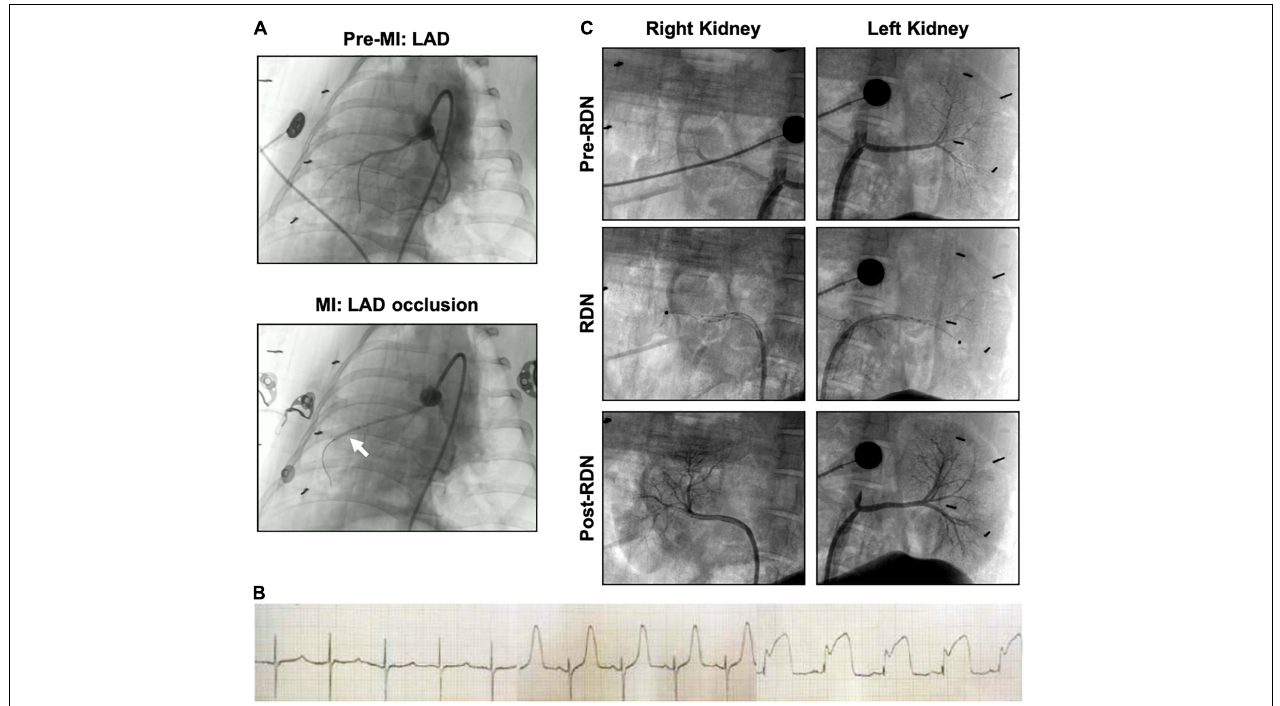
FIGURE 2 | Angiography of acute myocardial infarction and reperfusion (MI/R) and the RDN procedure in the porcine model. (A) Coronary artery angiography was performed before and during occlusion. The white arrow indicates the balloon position. (B) Representative ECG of the interventional procedure of MI/R. ST segment elevation of the anterior wall lead was observed. (C) Renal angiography was performed before, during, and after RDN in a bilateral manner. During the RDN procedure, the ablation catheter (black dot) can be observed in both renal arteries. Lack of stenosis was confirmed post-RDN.